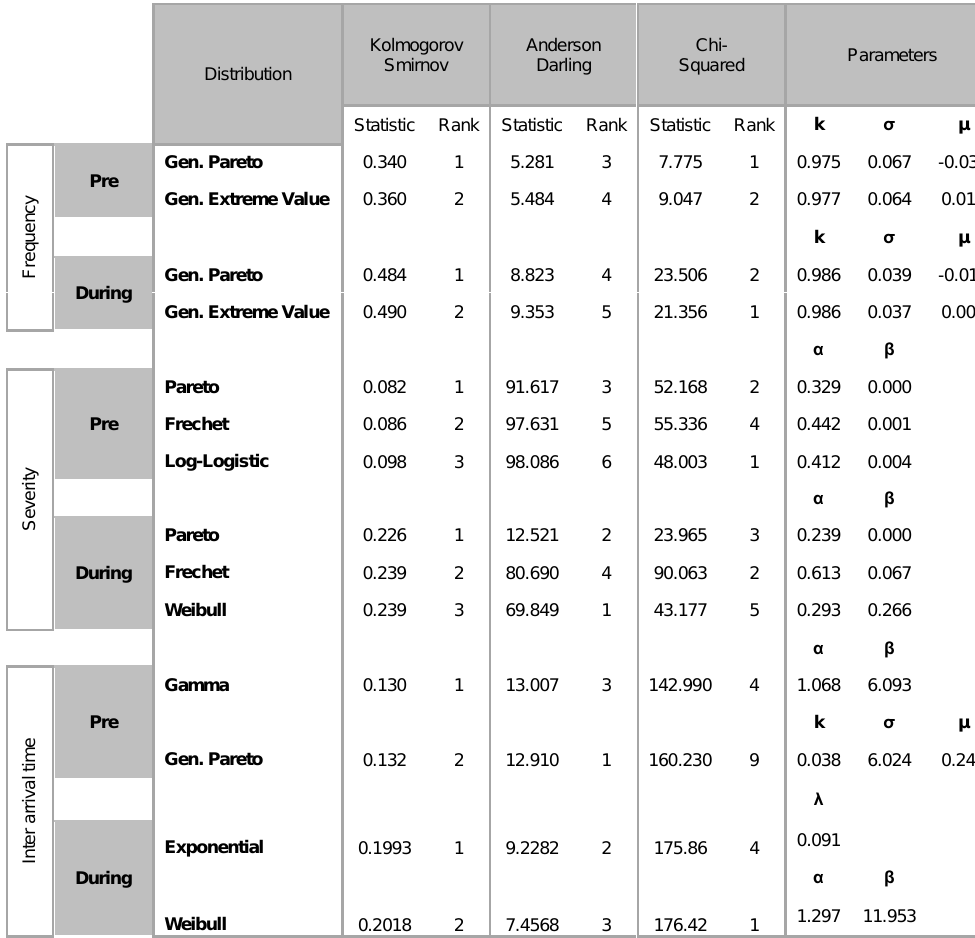
Summary statistics and goodness-of-fit test results for the frequency, severity and